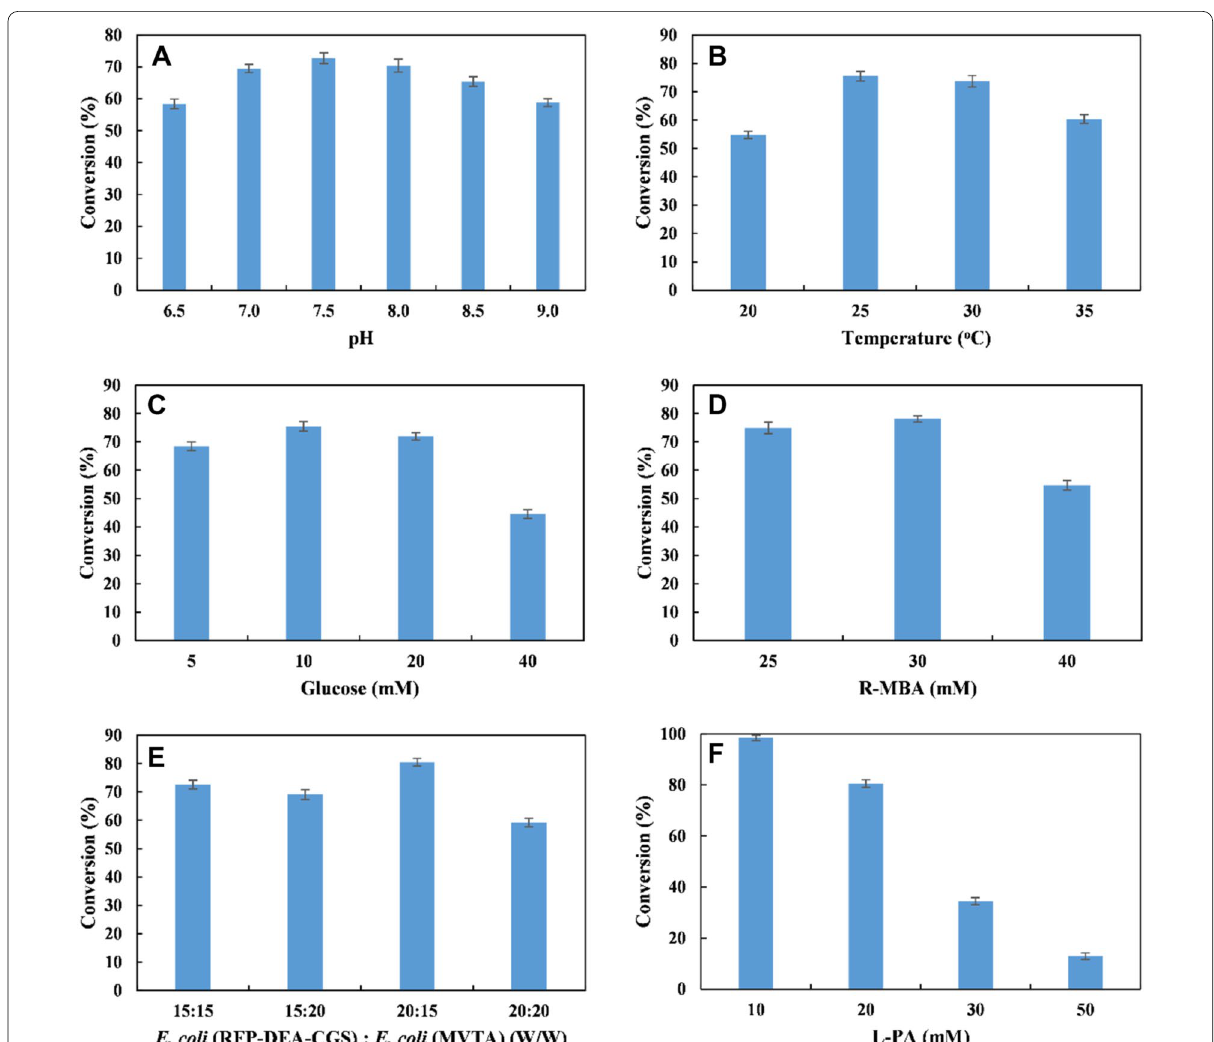
Fig. 4 Reaction condition optimization for conversion of L-PA 1 (20 mM) to ( S )-7 by the designed E. coli (RFP-DEA-CGS) and E. coli (MVTA) consortium. A Effect of different pH on the conversion of ( S )- 7 ; B effect of different temperature on the conversion of ( S )- 7 ; C effect of glucose concentration on the conversion of ( S )- 7 ; D effect of R-MBA concentration on the conversion of ( S )- 7 ; E effect of different cell density of E. coli (RFP-DEA-CGS) and E. coli (MVTA) on the conversion of ( S )- 7 ; F effect of different L-PA 1 concentration on the conversion of ( S )-